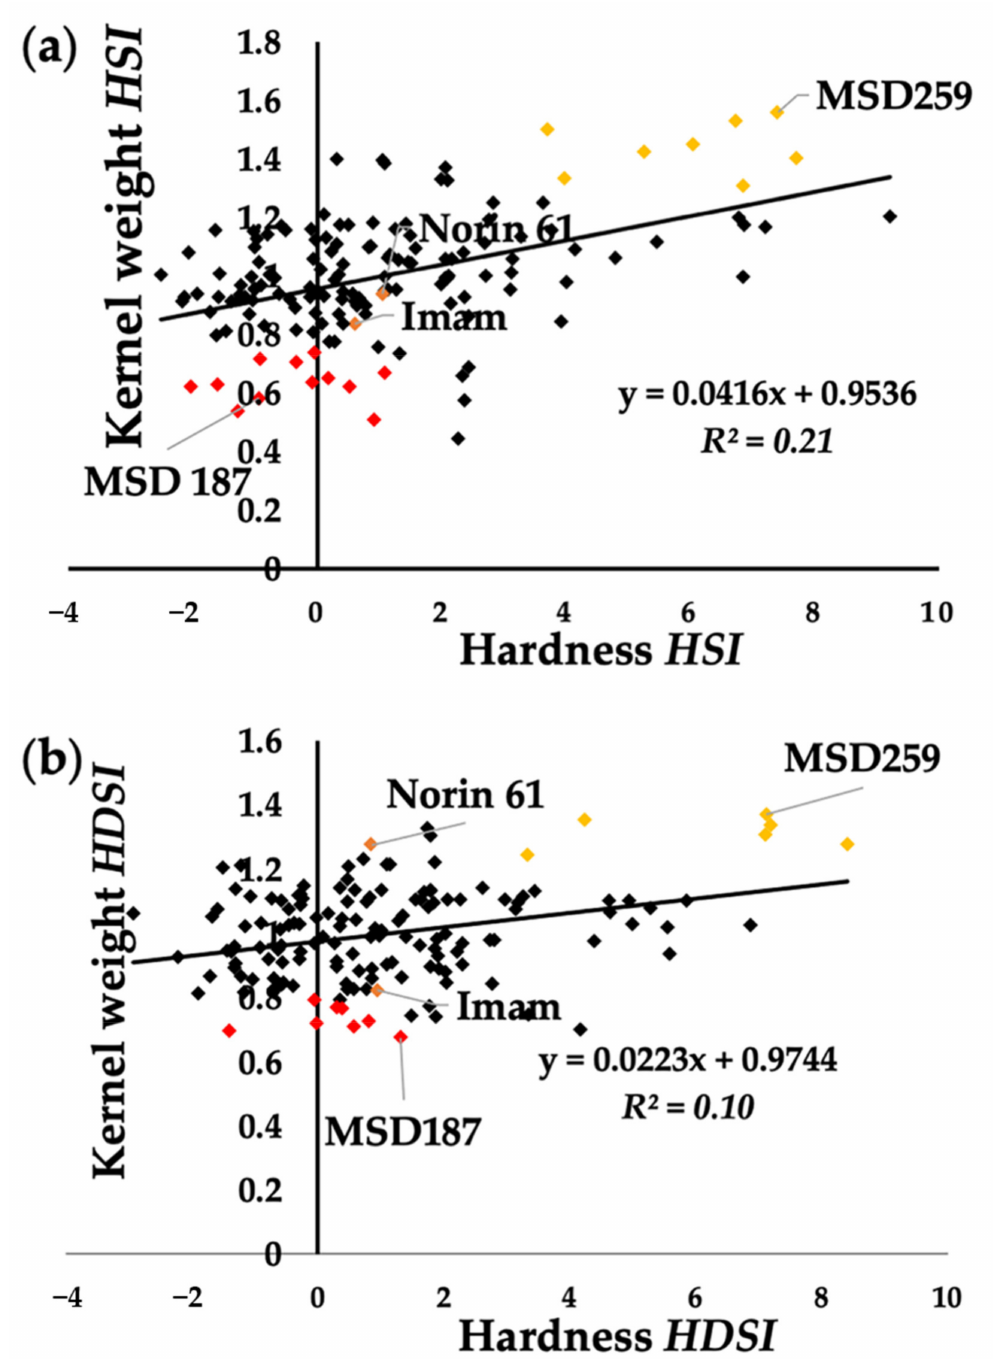
Figure 2. Relationship between kernel weight and hardness heat susceptibility index ( HSI ) ( a ). And heat-drought suscepti- bility index ( HDSI ) ( b ). Tolerant lines with low change in kernel hardness are indicated with red dots and sensitive lines with a high change in kernel hardness are indicated with yellow dots. ‘Norin 61’ is the background parent of the multiple synthetic derivatives (MSD) and ‘Imam’ is a heat-tolerant Sudanese